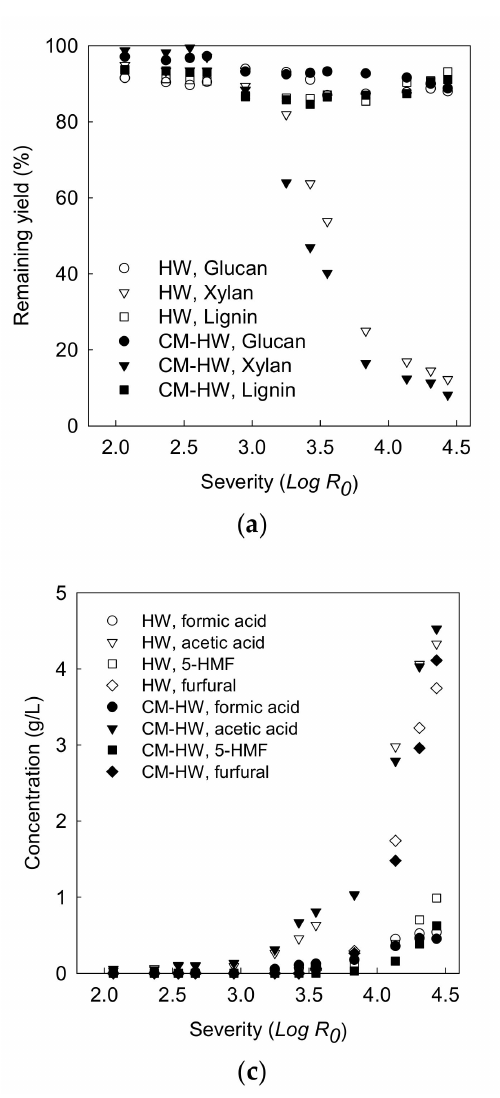
Figure 5. Reaction behavior of HW-treated and CM-HW-treated oak wood with reaction severities ( Log R 0 ) from 2.07 to 4.43. ( a ) Yields of glucan, xylan, and lignin in solids, ( b ) recovery yields of glucose and xylose in liquid hydrolysate, and ( c ) byproduct concentrations in liquid hydrolysate. Reaction conditions: temperature 120 ◦ C, 150 ◦ C, and 180 ◦ C; reaction time 30 min, 60 min, 90 min, and 120 min; L/S = 10